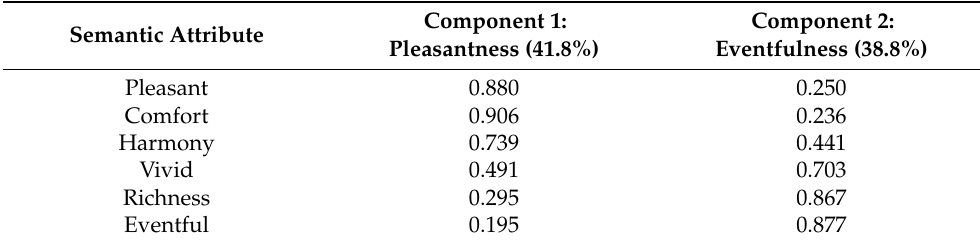
Table 3. Rotated component matrices of the PCA based on semantic attributes (numbers in paren- theses represent explained variance).